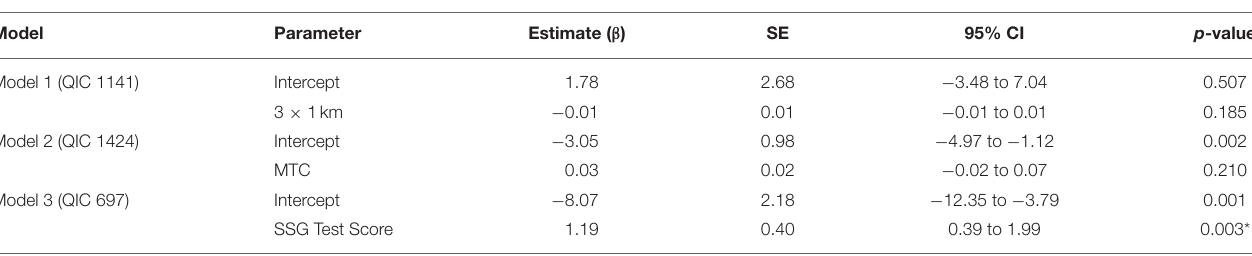
TABLE 2 | Univariate generalized estimating equations for prediction of coaches’ vote.